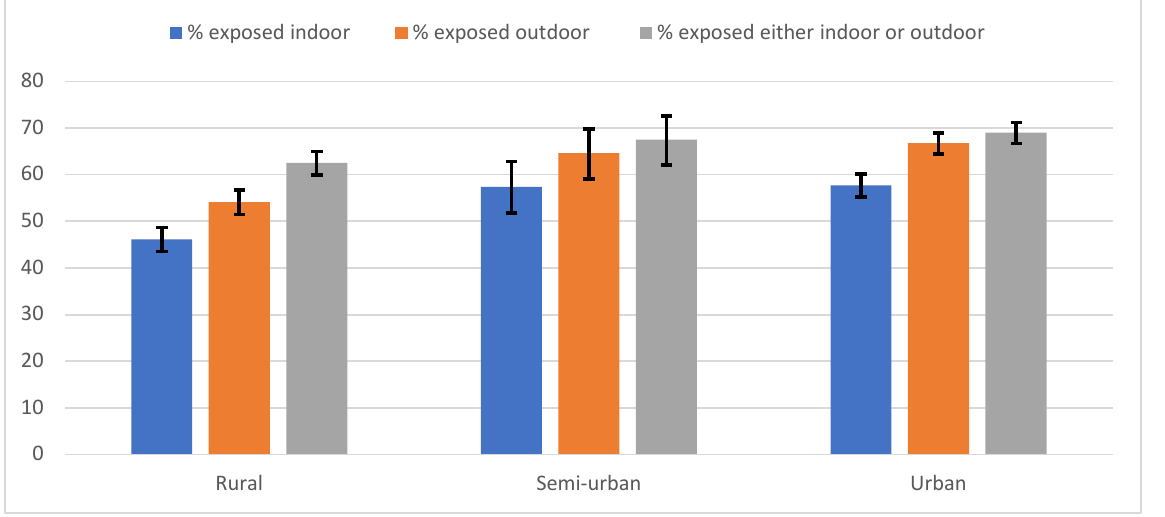
Figure 2. Exposure to second-hand smoke by residence. N.B.: The vertical lines on top of the bars represent the 95% Confidence Intervals.